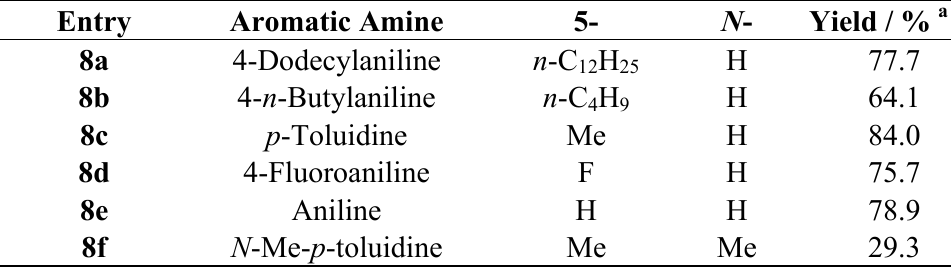
Table 6. Isolated yields of indolino[60]fullerene derivatives.